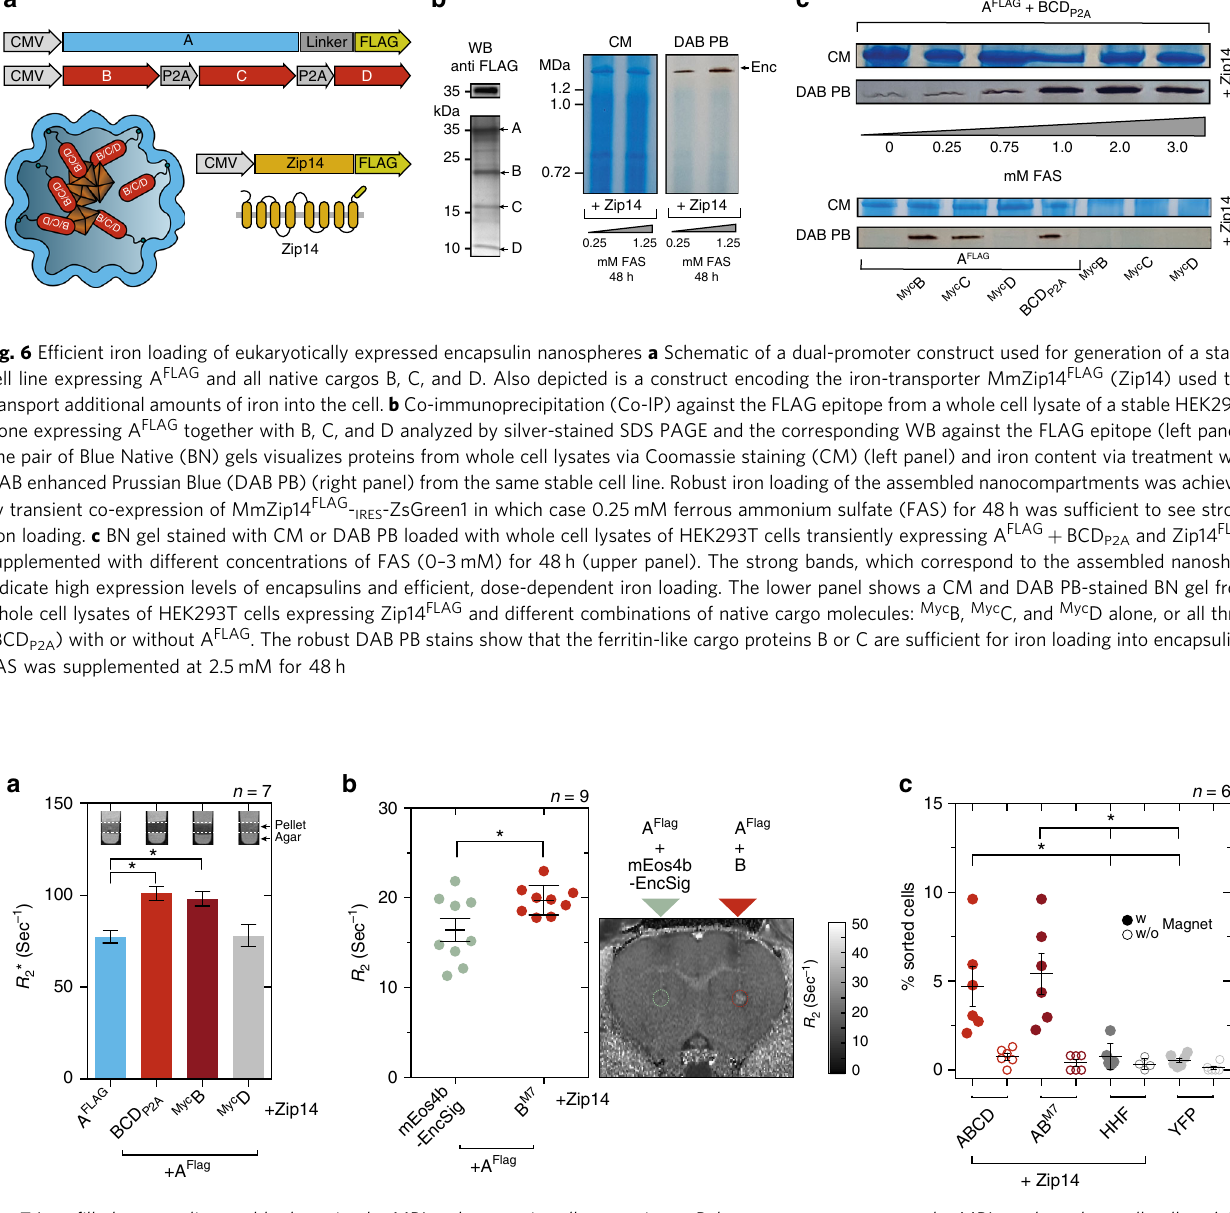
Fig. 7 Iron- fi lled encapsulins enable detection by MRI and magnetic cell separation. a Relaxometry measurements by MRI conducted on cell pellets (~10 7 cells) from HEK293T cells transiently expressing A FLAG + BCD P2A , Myc B, or Myc D, or A FLAG alone (1 mM FAS for 24 h and expression of Zip14 FLAG ). Expression of A FLAG with BCD P2A or with Myc B showed a signi fi cantly enhanced R 2 * -relaxation rate as compared with A FLAG alone or loaded with Myc D; ferritin-like cargo B was suf fi cient to generate an increase in R 2 * in the presence of the A FLAG nanocompartment ( p = 0.0047, Kruskal – Wallis, n = 7 from four independent experiments, stars indicate signi fi cance at α = 0.05 from Dunn ’ s multiple comparisons test vs. A FLAG ; the bars represent the mean ± SEM). The insets show MRI slices (13.5 ms echo time) through test tubes in which cells were pelleted on a layer of agar. b In vivo MRI detection of HEK293T cells transiently co-expressing A FLAG together with ferritin-like B M7 that were xenografted into rat brains. As compared to cells co-expressing A FLAG together with the fl uorescent protein mEos4b-EncSig as control cargo, we observed signi fi cantly increased transverse relaxation rates ( p = 0.0078, Wilcoxon matched-pairs signed rank test, n = 9) measured at the injection site for A FLAG + B M7 expressing cells 24 h post injection. The horizontal lines represent the mean ± SEM. The image on the right shows a coronal R 2 map through a rat brain with the regions of interest (ROIs) de fi ned over the injection sites by dashed circles. c HEK293T cells were co-expressing A FLAG and BCD P2A , A FLAG and B M7 , or human H-chain ferritin (HHF) as a control together with Zip14 and were treated with 2.5 mM FAS for 48 h. Additional control cells were expressing only EYFP. Independent cell suspensions were subsequently sorted on commercial magnetic separation columns inside and outside the magnetic fi eld to control for unspeci fi c retention in the mesh of the column. The fraction of cells separated in the magnetic fi eld for both encapsulin:cargo conditions was signi fi cantly higher than for any of the control conditions HHF + Zip14 or YFP ( p = 0.0007, Kruskal – Wallis, n = 6 from three independent experiments, stars indicate signi fi cance at α = 0.05 from Dunn ’ s multiple comparisons test across all conditions with magnetic fi eld; the horizontal lines represent the mean ±